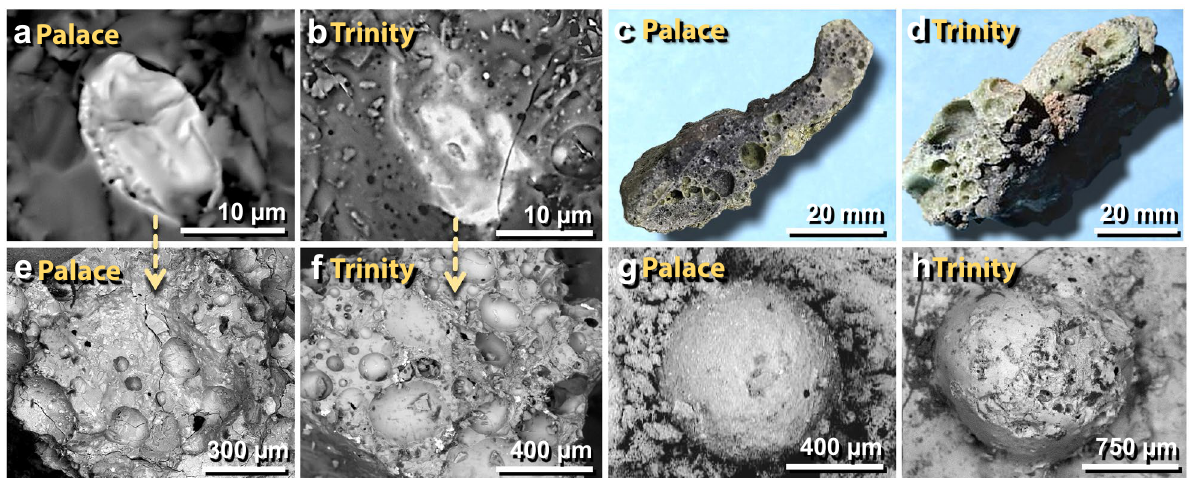
Figure 51. Comparison of melted materials from TeH with those from the Trinity atomic bomb test. ( a ), ( b ) SEM images compare a melted, decorated zircon embedded in mudbrick meltglass from the palace with similar material from Trinity. ( c ), ( d ) Photomicrographs compare a melted potsherd from the palace with similar- looking material from Trinity. ( e ), ( f ) The melted zircons in panels ‘ a ’ and ‘ b ’ were found in highly vesicular glass like these from the palace and the Trinity site, respectively. ( g ), ( h ) SEM images of a spherule fused onto mudbrick meltglass from the palace and a spherule embedded into trinitite from the Trinity atomic